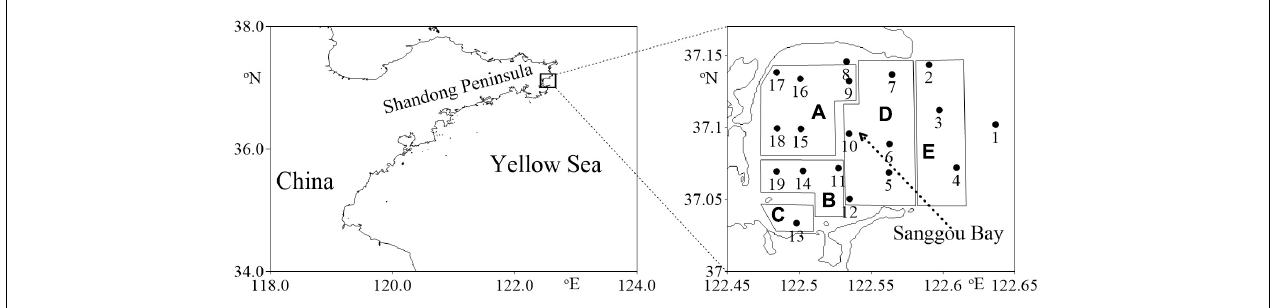
FIGURE 1 | Location of the sampling stations superimposed on the aquaculture area [ (A) scallop monoculture area, (B) oyster monoculture area, (C) fish monoculture area, (D) kelp and bivalve polyculture area, (E) kelp Saccharina japonica monoculture